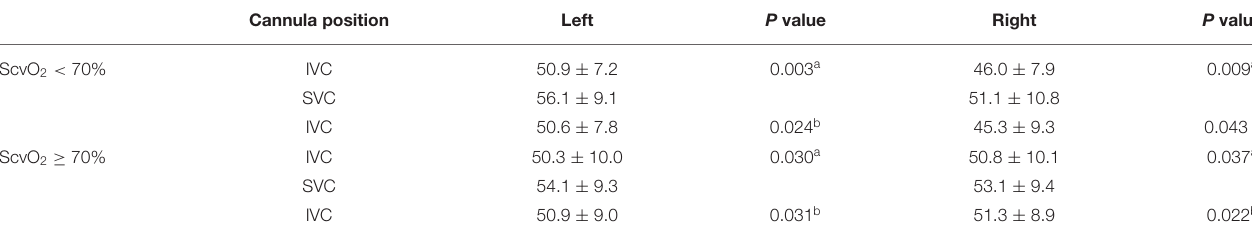
TABLE 4 | Cerebral oxygen saturation in upper body hypoxia group (ScvO2 < 70%) and upper body normoxia group (ScvO2 ≥ 70%).